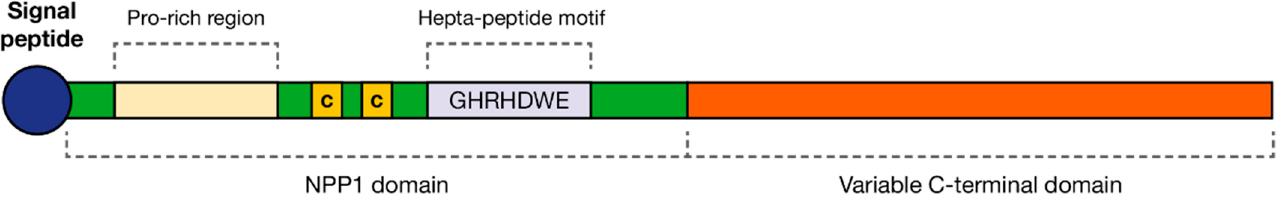
Figure 3. Structure of Phytophthora cNLPs. A signal peptide is present followed by a necrosis-inducing Phytophthora protein 1 (NPP1) domain containing a 30–45 proline rich region and a Hepta-peptide GHRHDWE motif at around 110–130 aa. In cNLPs, there are two conserved cysteines present between the Pro-rich region and Hepta-peptide motif—ncNLPs have four conserved cysteines in this region.